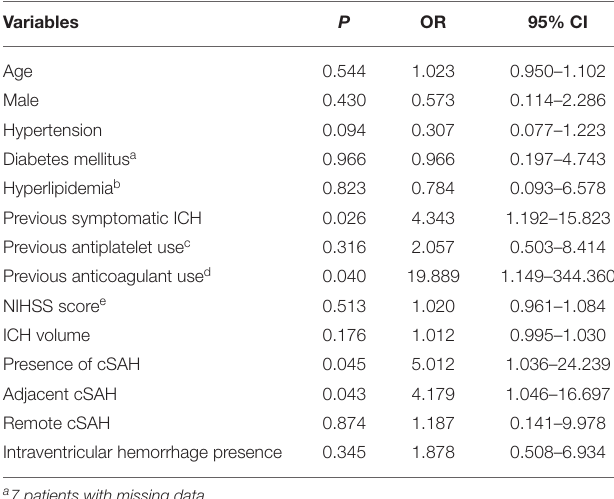
TABLE 2 | Univariate regression analysis of factors for recurrent ICH within 2 weeks.